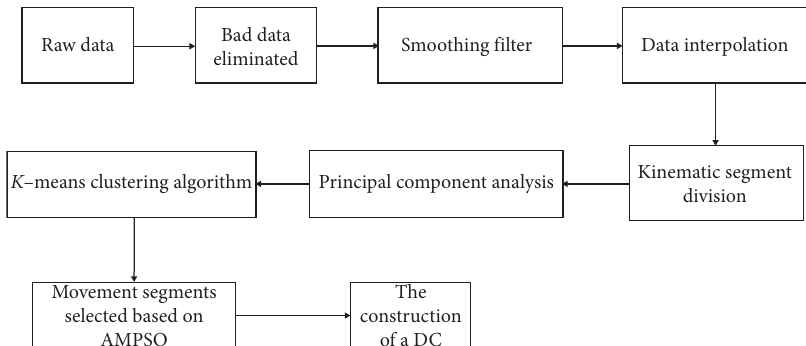
Figure 2: Driving cycle construction flowchart.